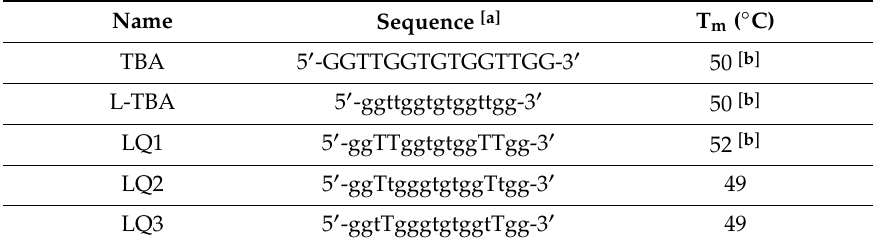
Table 1. Sequences investigated and their melting temperatures (T m